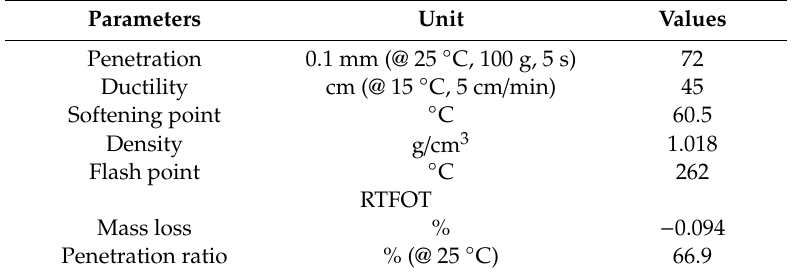
Table 1. Technical parameters of styrene–butadiene–styrene (SBS)-modified asphalt.